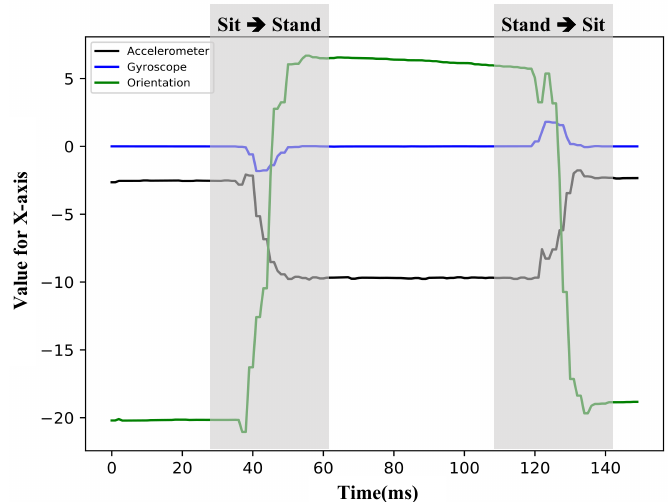
Figure 2. Change in the X-axis for each type of sensory data.